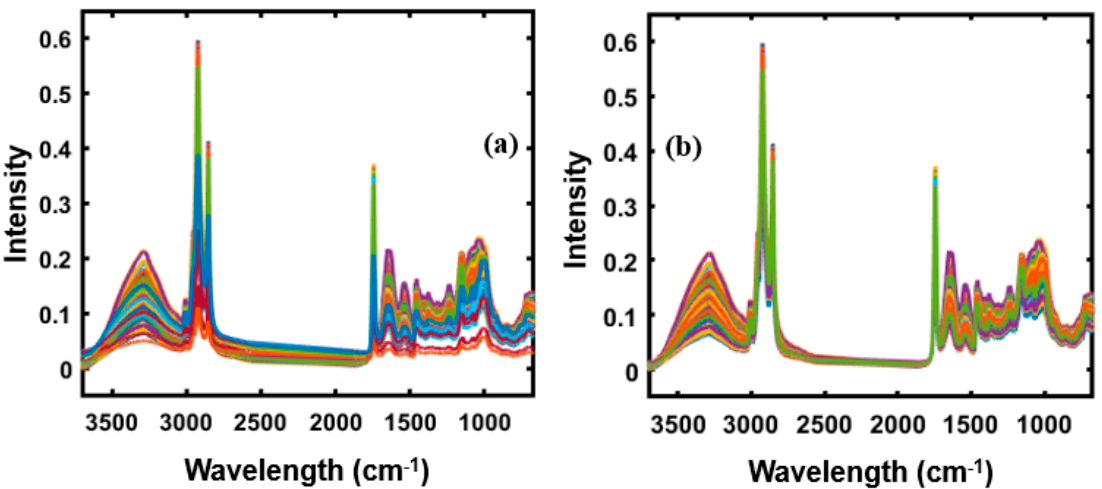
Figure 1. ( a ) Original FT-IR spectra of apricot-adulterated almond samples, and ( b ) the standard normal variate (SNV) preprocessed spectral data.